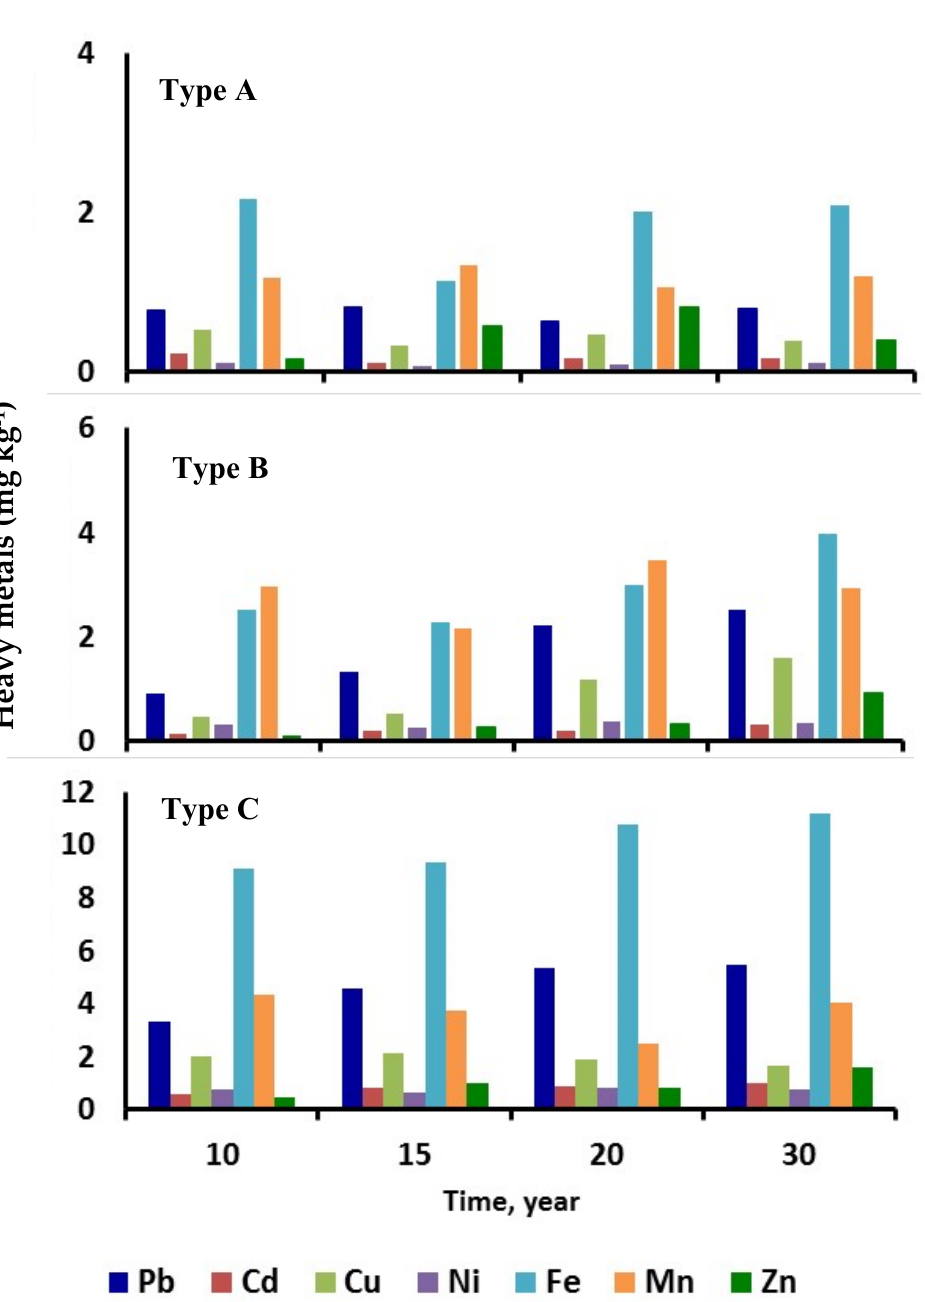
Figure 1. Temporal changes in soil heavy metal content due to wastewater addition in different studied soils. Type A: soils irrigated with Nile water; type B: soils irrigated with agricultural wastewater; type C: soils irrigated with raw urban wastewater.